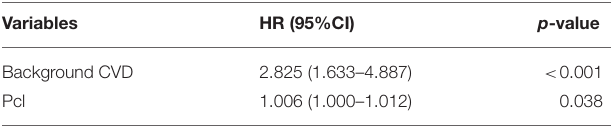
TABLE 4 | Multivariate Cox regression (stepwise backwards) models for cardiovascular events [expressed as hazard ratios, 95% CI’s, and p-value]. Variables HR (95%CI) p -value Background CVD 2.825 (1.633–4.887) < 0.001 Pcl 1.006 (1.000–1.012) 0.038 Adjusted for age, diabetes, BMI, serum albumin, serum angiopoietin 2; CVD, cardiovascular disease; Pcl, peritoneal protein clearance; BMI, body mass index; Angpt, angiopoietin.